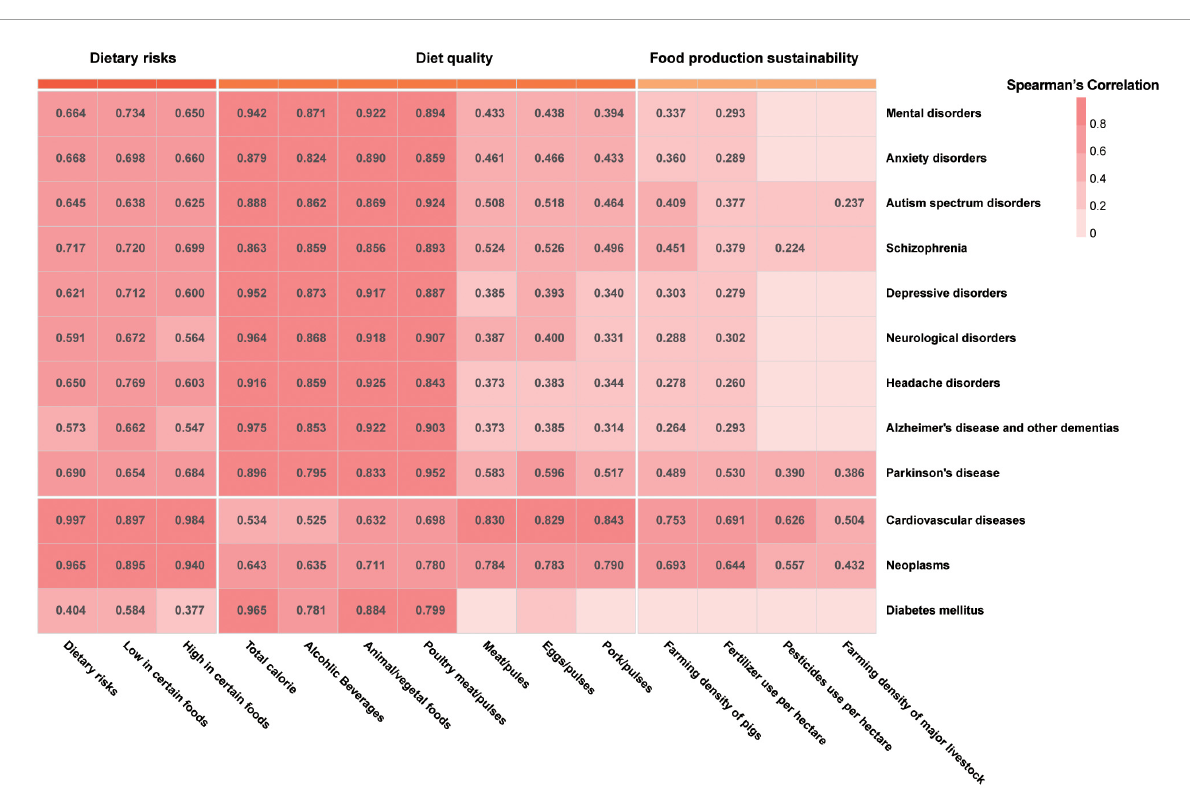
foods are being replaced by processed foods, delivery foods, and restaurant foods. All the above indicate that China is going through the westernization or industrialization of